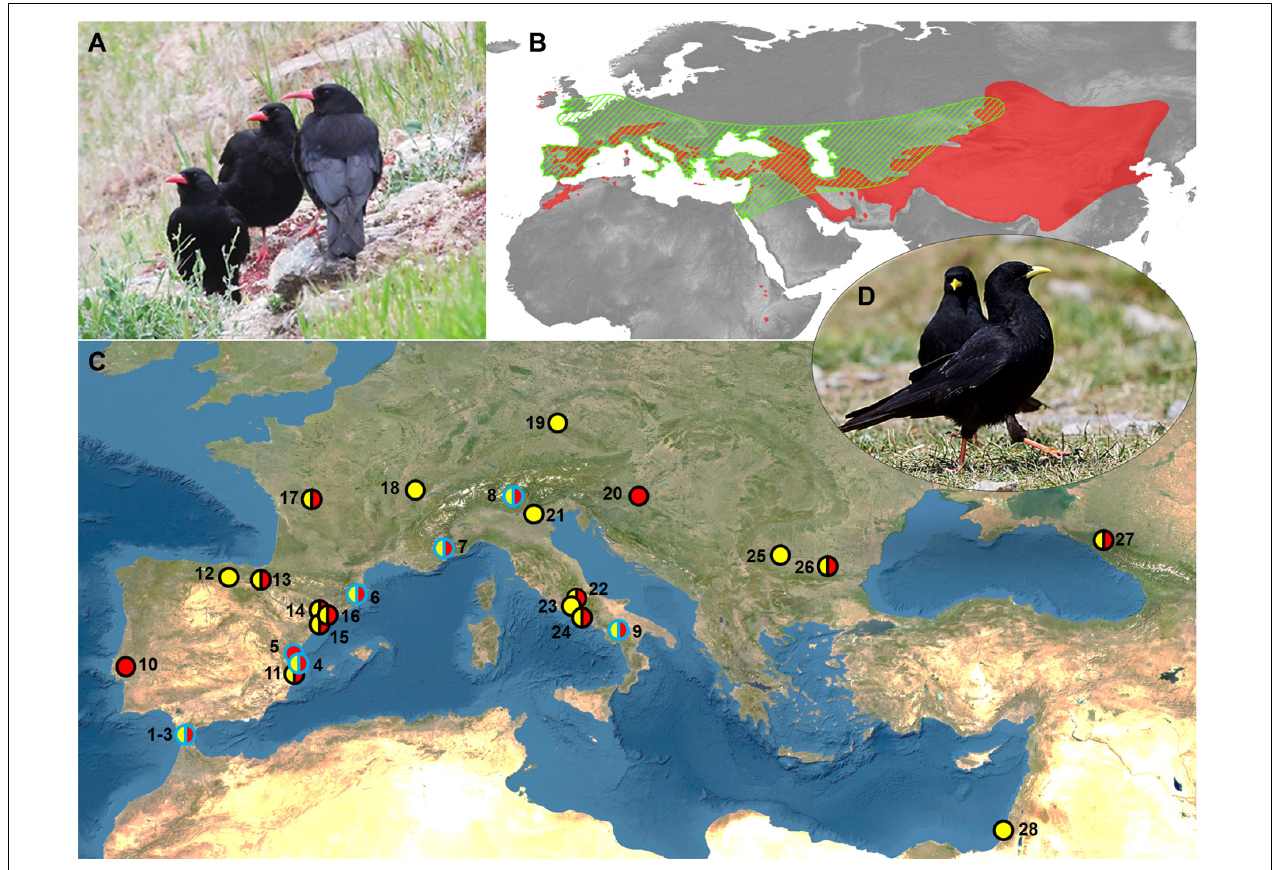
FIGURE 1 | (A) Red-billed choughs. (B) Map showing the current pooled distribution range of red-billed and Alpine choughs (red area, according to BirdLife International and Handbook of the Birds of the World, 2019; freely available at http://datazone.birdlife.org/species/requestdis), and estimated range of Neanderthals (green barred area; modified from Ryulong, 2016; freely available at https://www.ancient.eu/image/5958/geographical-range-of-neanderthals/). (C) Sites with evidence of both Neanderthal occupation and presence of chough skeletal elements. The presences of red-billed choughs, Alpine choughs or both species in the sites are represented by red, yellow, or both-colors circular markers. Markers with blue borders represent sites with presence of processed chough fossils remains, while circles with black borders represent sites where processing marks were not searched for or not recorded. References of the sites:1–3: Gorham, Vanguard, Ibex caves; 4: Cova Negra; 5: Bolomor; 6: Arbreda; 7: Pié Lombard; 8: Fumane; 9: Grotte de Castelcivita; 10: Figueira Brava; 11: Beneito; 12: El Castillo; 13: Labeko koba; 14: Romaní; 15: Gegant; 16: Coll Verdaguer; 17: Combe Grenal; 18: La Baume de Gigny; 19: Sesselfelsgrotte; 20: Vindija; 21: Grotta del Broion; 22: Valle Radice; 23: Grotta Guattari; 24: Grotta di Sant Agostino; 25: Temnata; 26: Bacho Kiro; 27: Mezmaiskaya; 28: Kebara. Sources are shown in Table 1 and Supplementary Table 1 . (D) Alpine choughs. Maps were generated with QGIS software and modified with Microsoft PowerPoint 2010 (Microsoft Corporation, Redmond, WA, United States, https://www.microsoft.com/pt-pt/microsoft-365/previous-versions/office-2010) under CSIC Organizational License. Photo credits: A (G. Blanco), D (J.J.